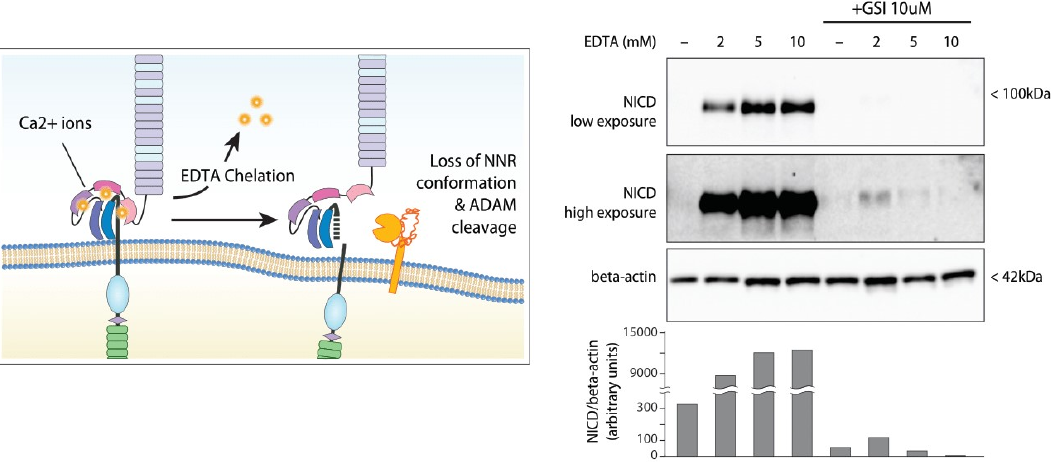
Figure 2. Ligand-independent NOTCH1 activation elicited by EDTA. Left panel: molecular interactions within the NRR are stabilized by divalent calcium ions; chelation by EDTA disrupts the three-dimensional conformation, allowing cleavage at S2 by ADAMs and subsequent gamma- secretase cleavage at S3 (not shown). Right panel: prototypic example of MEC1 cells treated with increasing concentrations of EDTA for 3 h showing evident accumulation of cleaved NICD, which is reversed by gamma-secretase inhibition (GSI). Original blots see Supplementary File